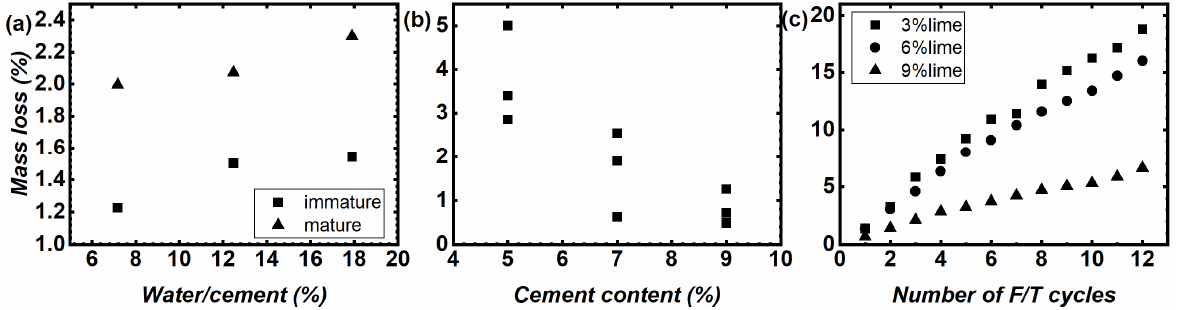
Figure 3. Mass loss caused by F/T cycles: ( a ) soilcrete with different water content under 12 F/T cycles (adapted from [55]), ( b ) soilcrete with different cement content under 12 F/T cycles (adapted from [34]), and ( c ) mass loss increases with the increase in F/T cycles (adapted from [57]).